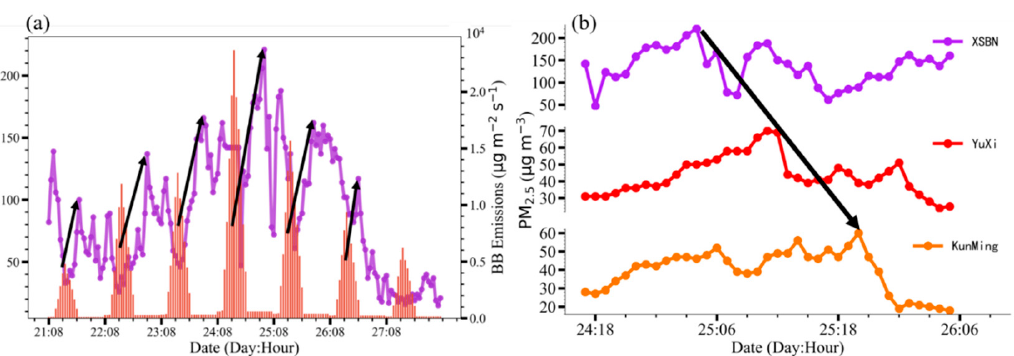
Figure 4. ( a ) Hourly changes in PM 2.5 concentrations observed in XSBN (purple line) and BB PM 2.5 emission rate averaged in Domain 2 from FINN (red bar) The black arrows indicate the PM 2.5 concentrations increase with increasing BB emission intensity. ( b ) Hourly changes in PM 2.5 concentrations in three downstream sites, XSBN, Yuxi, and Kunming, from 18:00 of 24 March to 06:00 of 26 March. The black arrow indicates the intervals of the lag time along with the regional PM 2.5 transport from XSBN to Kunming during the air pollution episode.